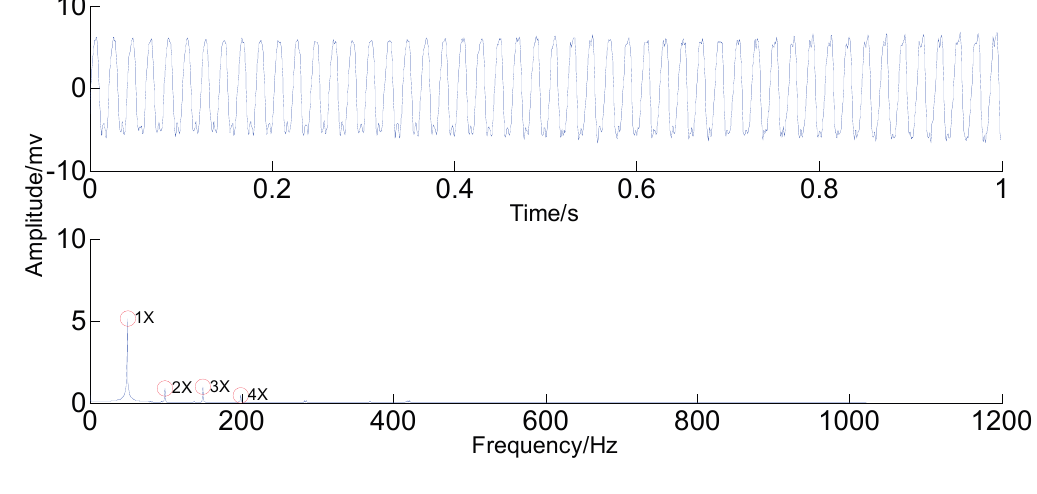
Figure 19. Reconstruction of rubbing